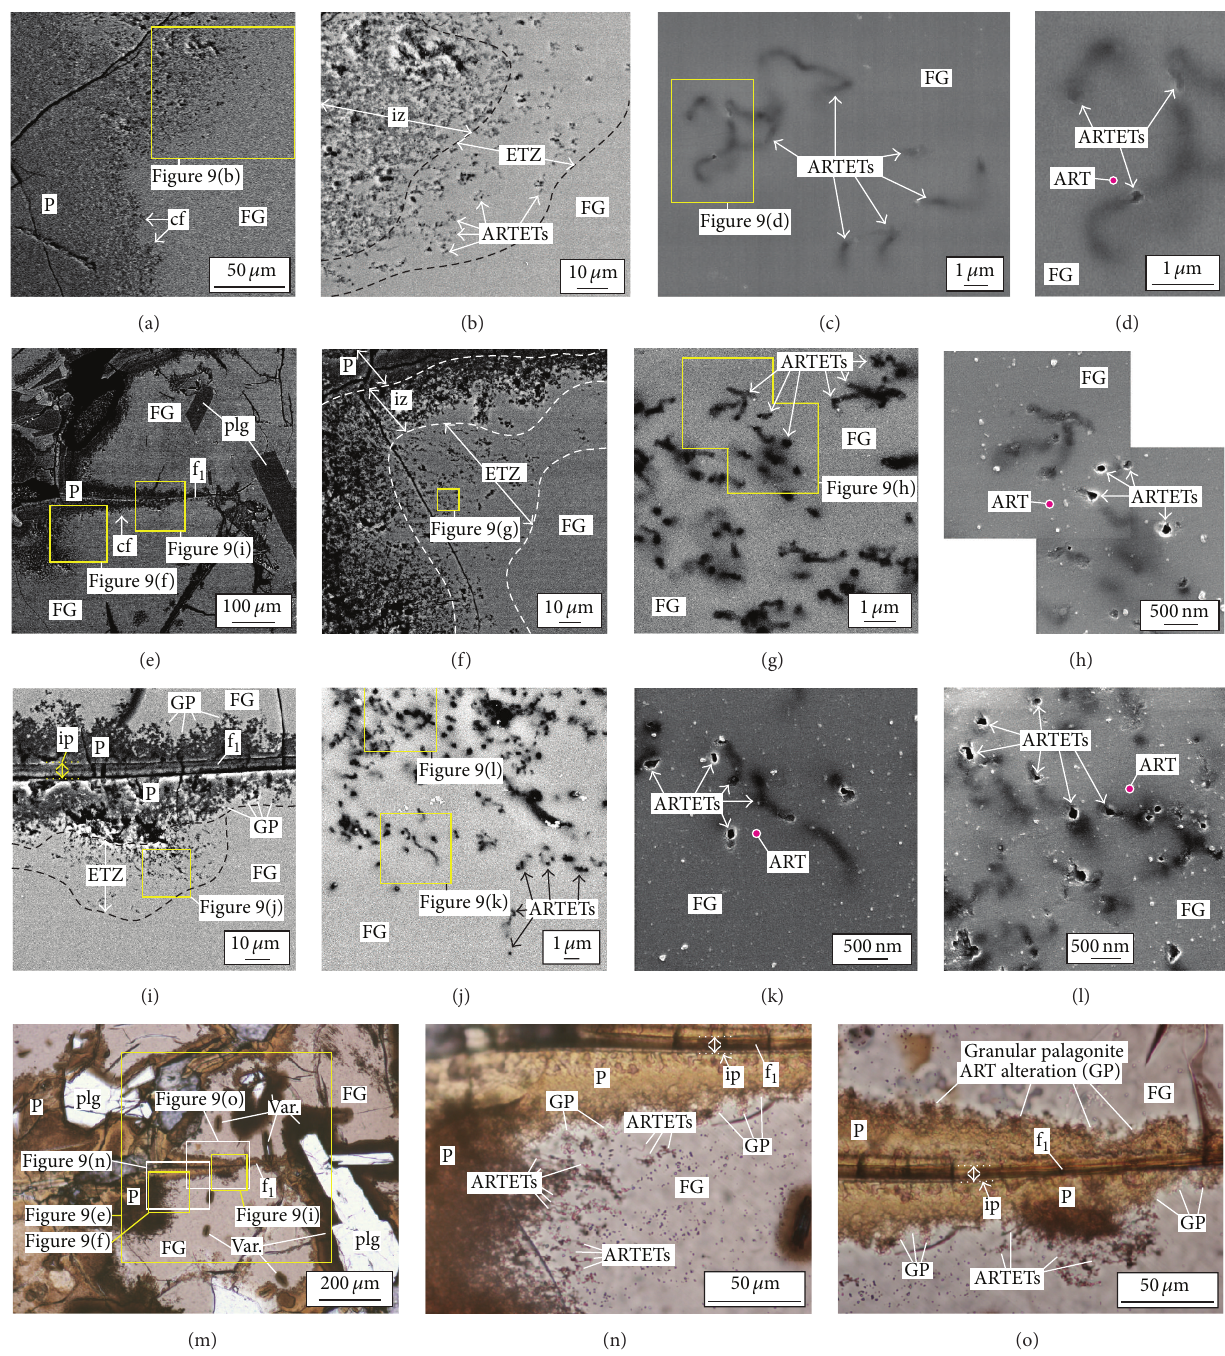
Figure 9: Petrographic and SEM study of the alpha-recoil track etch-tunnel (ARTET) zone at the glass-palagonite interface (in polished petrographic thin section). (a–d): sample DSDP-418A-75-3[120–123] ; (e–o): sample DSDP-418A-68-3[40–43] . The images shown in (a, b, e–g, i, and j) are BSE images, while (c, d, h, k, and l) are secondary electron images. Note: (c) and (d) are close-ups from Figure 7(c). Pink dots in (d, h, k, and l) represent hypothetical ARTs—note the striking similarity in size between the real etch-tunnels and the ARTs. Photomicrographs (taken in plane polarized light) in (m–o) show the same petrographic area shown in (e–l). ART: alpha-recoil track; ARTETs: alpha-recoil track etch-tunnels; cf: corrosion front; ETZ: etch-tunnel zone; f 1 : early fractures associated with palagonite; FG: fresh basaltic glass; GP: granular palagonite ART alteration; ip: initial palagonite; iz: intermediate zone (between the etch-tunnel and palagonite zones); P: palagonite zone; plg: plagioclase; Var.: